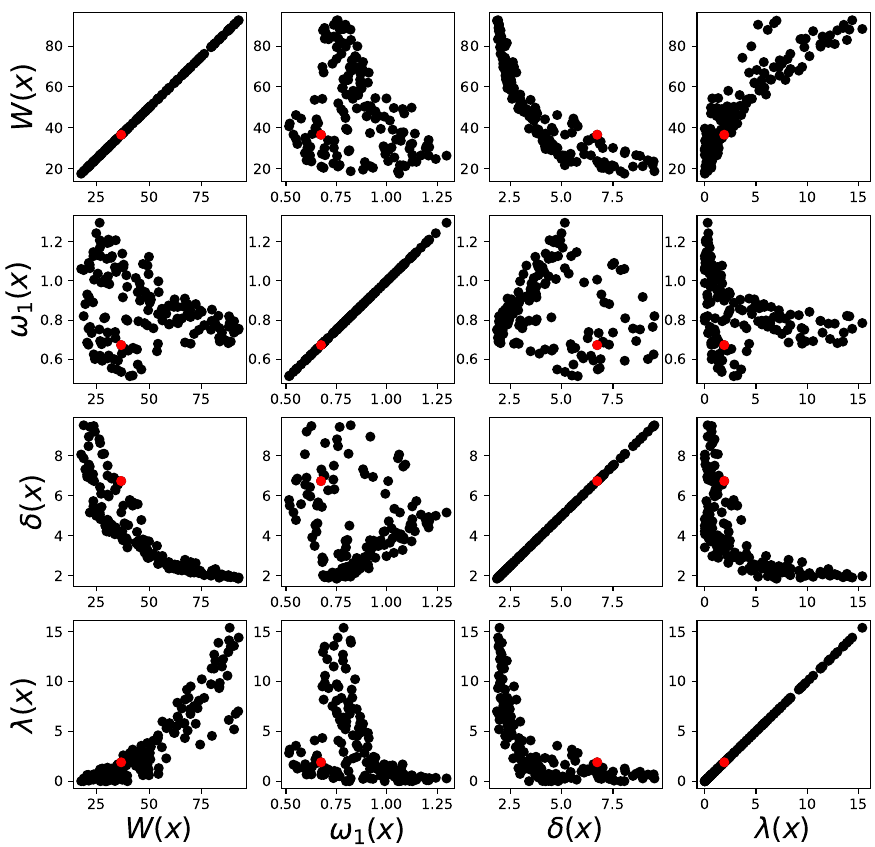
Figure 17. Scatter plot of the PF obtained for